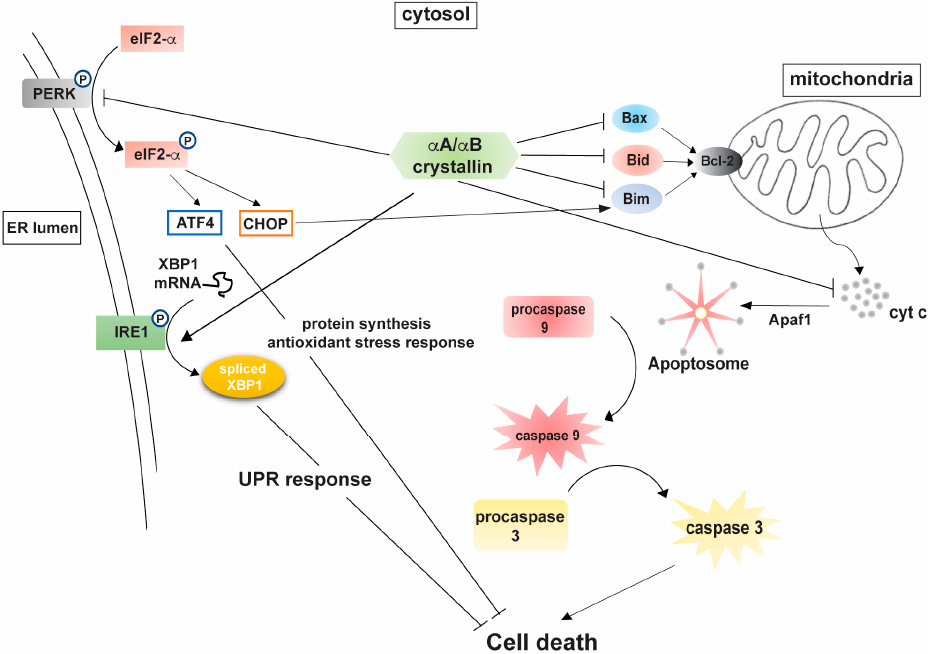
Figure 1. Mechanistic analyses of α -crystallin mediated cytoprotection. Abbreviation list: cyt c, cytochrome c; Apaf1, apoptotic protease activating factor 1; eIF-2 α , eukaryotic translation initiation factor 2 α ; ATF4, activating transcription factor 4; CHOP, C/EBP homologous protein; XBP1, X-box binding protein; IRE1, Inositol requiring enzyme 1; PERK, Protein kinase R-like ER kinase; ER, endoplasmic reticulum; UPR, unfolded protein response.